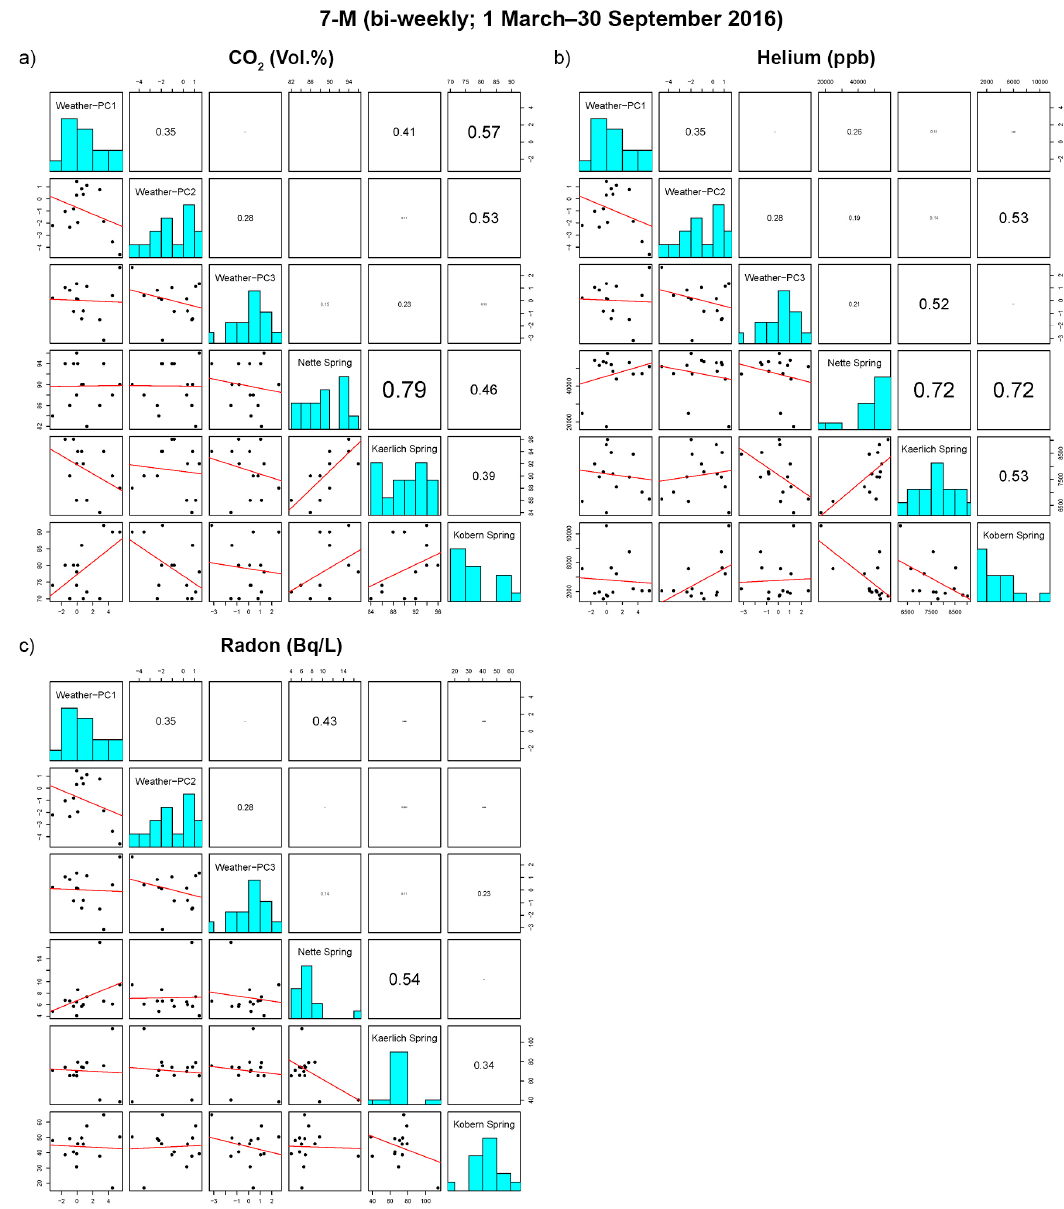
Figure A1. Coe ffi cients of the principal components analysis of weather variables with geogenic gas concentrations for ( a ) CO 2 , ( b ) He, and ( c ) Rn for the mineral springs during the 7-M campaign. The histograms on the diagonal illustrate the distribution of data of each of the three principal axes describing meteorological conditions (see also Tables 2 and 3); the plots below the diagonal illustrate the raw data (symbols) and pair-wise linear regression relationships (red lines) for each corresponding pair of variables along the diagonal, and the panels above the diagonals report the pair-wise correlation coefficients (font size scaled to the coefficients).